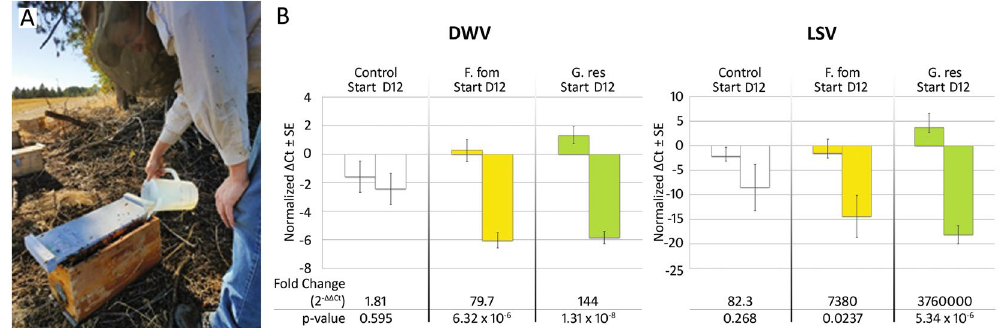
Figure 3. Fungal extracts reduce DWV and LSV levels in field trials. ( A ) Fungal extracts were mixed into sucrose solution and fed to bees using in-hive feeders commonly used in beekeeping. (B) Both Fomes and Ganoderma extracts significantly reduced DWV and LSV levels in field trials using 5-frame colonies with bees divided from a common population. Bees were sampled for virus levels at the start of treatment and 12 days later. Colonies fed G. resinaceum extracts exhibited a 79-fold greater reduction in DWV and a 45,000-fold greater reduction in LSV compared to controls fed sugar syrup. Quantitative PCR Δ Ct values are normalized to the mean starting virus levels across all groups. Photo: